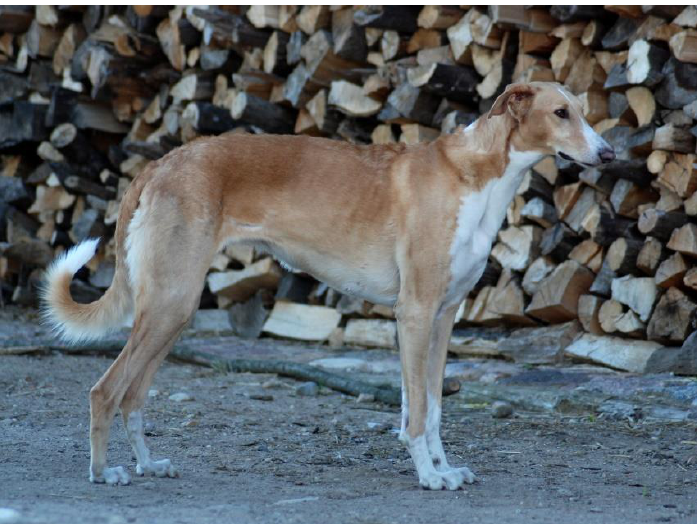
Figure 1. Body of a Polish Greyhound, female: IZIS Akacjana—owner Marta Kościańska (photo: Marta Kościańska).